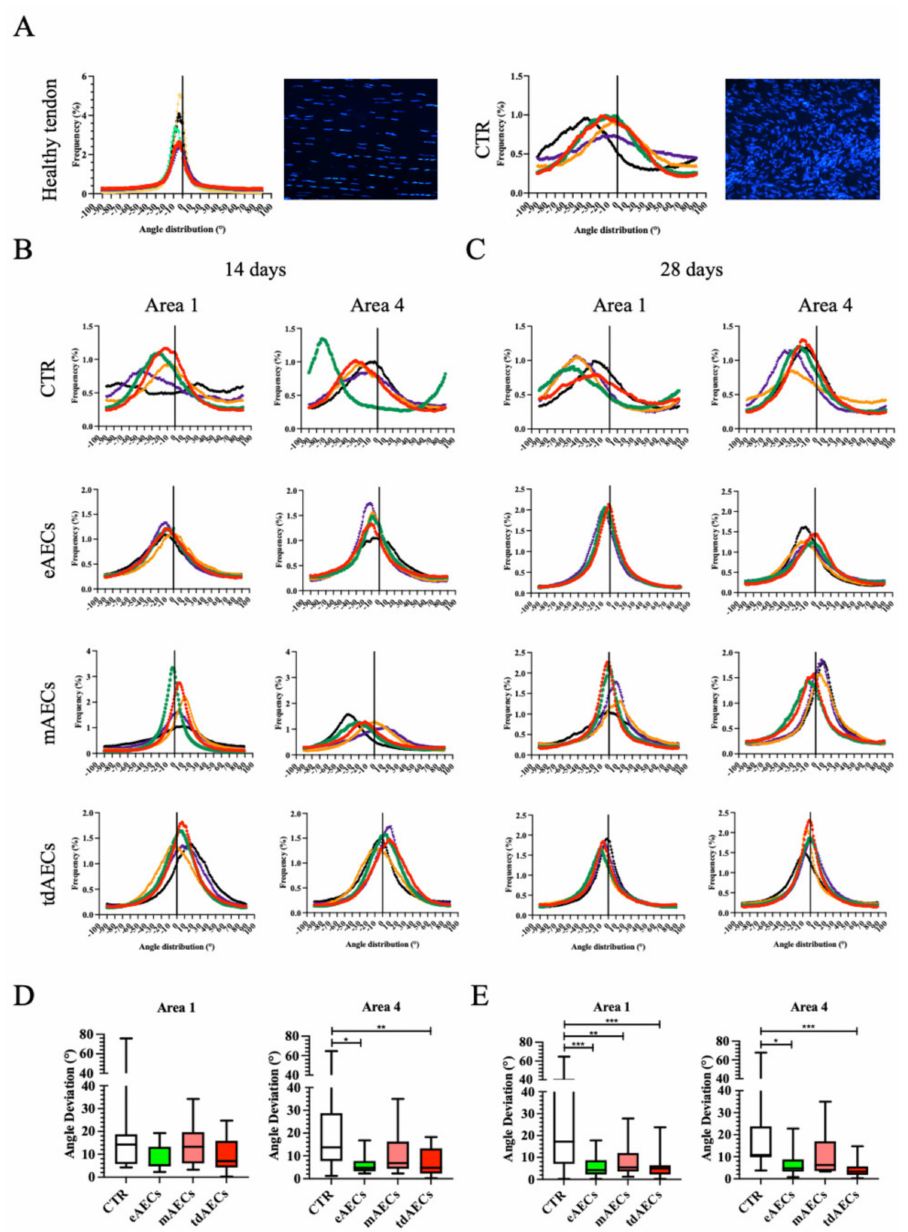
Figure 8. Directionality analyses on cell orientation of the different samples at 14 days and 28 days. ( A ) Representative directionality curves of the analyzed samples within healthy tendon area and CTR. Representative graphs showing the distribution of cell direction within area 1 and 4 in healing tendons under different conditions assessed through directionality of ImageJ at ( B ) 14 days and ( C ) 28 days. Histograms showing the angle deviation within healing tendons under different treatment conditions within area 1 and area 4 normalized to the healthy tendon area, used as reference for the analyses at ( D ) 14 days and ( E ) 28 days. Statistically significant values were set up for * p < 0.05, ** p < 0.01, and *** p < 0.0001. The quantitative data were expressed as mean ± S.D. The overall results on cellularity and ECM protein remodeling reinforced the evidence of AECs’ role in accelerating tendon healing, converging towards the hypothesis of a more targeted regenerative action of eAECs and